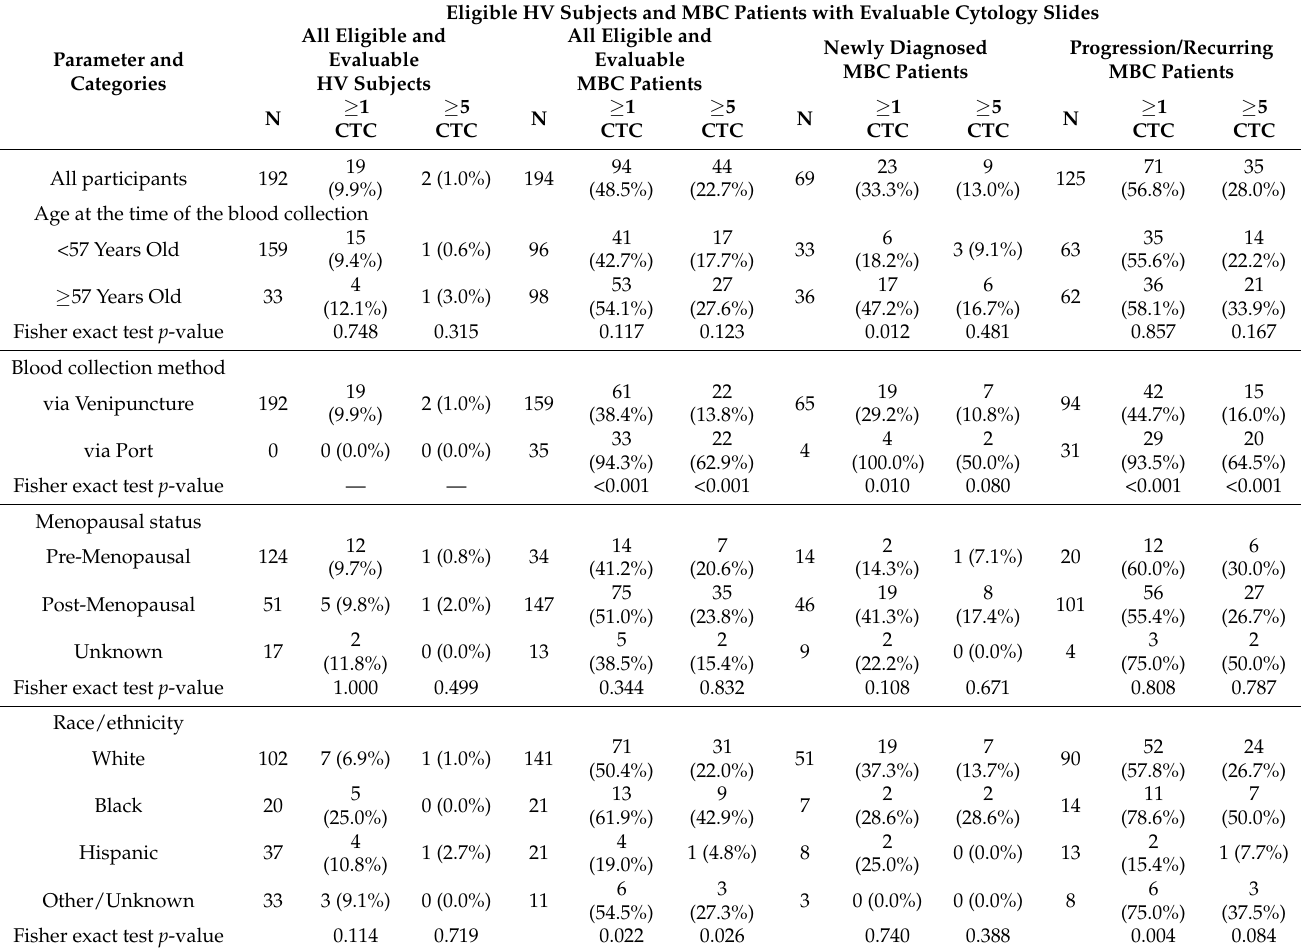
Table 2. CTC prevalence rates from initial cytopathology review in MBC patients and HVs by demographic and clinical